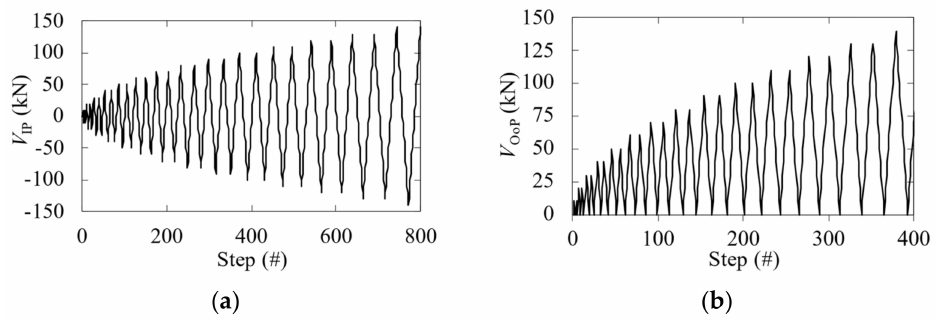
Figure 18. Cyclic, quasi-static load protocols. ( a ) IP; ( b ) OoP drift force protocol.